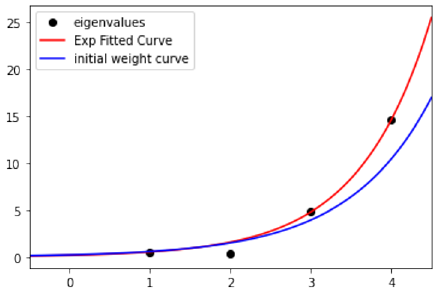
Figure 1 . L 24 ( k = 200) solution with exponential fit loss ∼ 0 . 34 . For this functional on su (4) ,